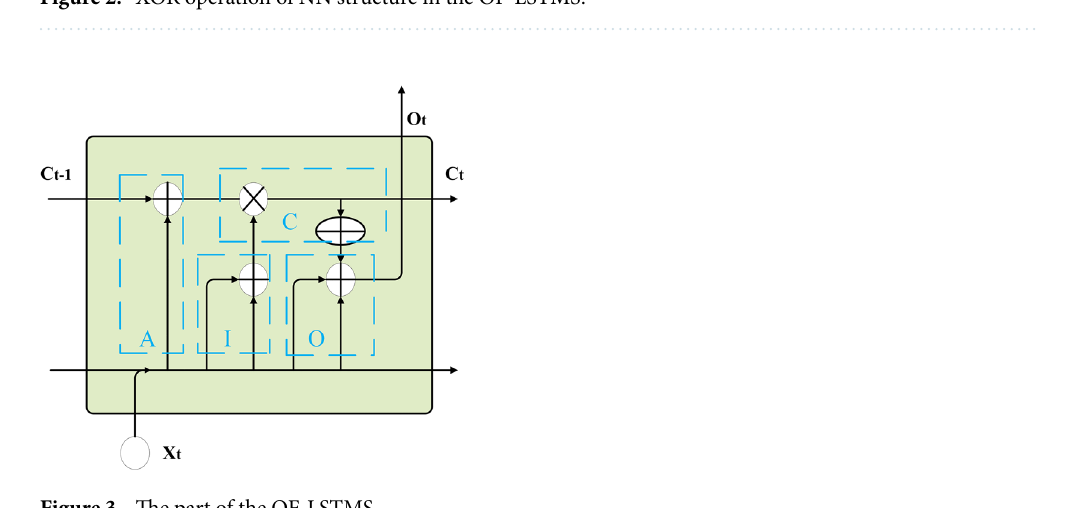
Figure 3. The part of the